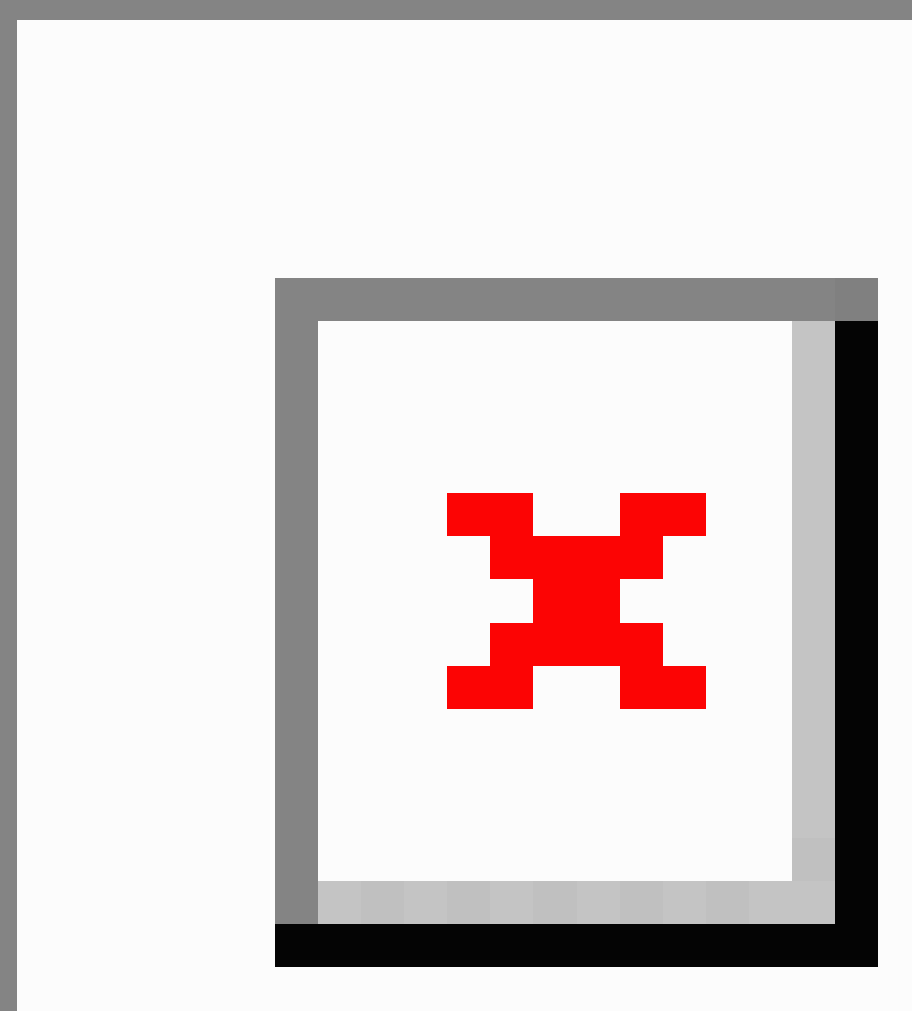
Figure 4. Change in scores between baseline and imputed posttest